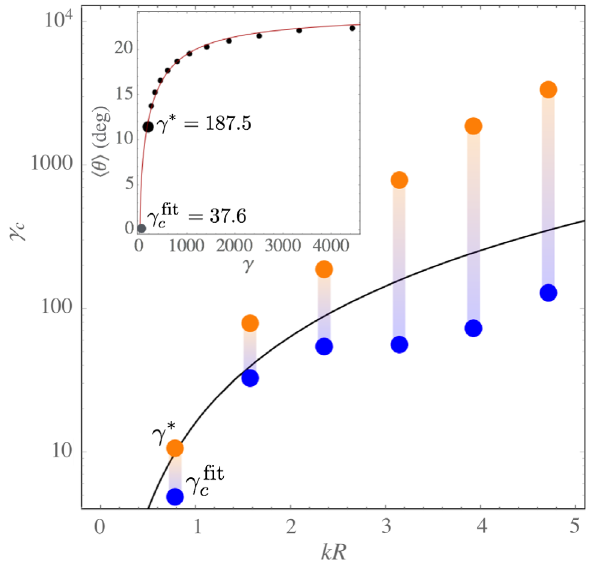
FIG. 6. Confirmation of the linear stability prediction of γ c from Fig. 2 compared to the upper ( γ (cid:4) ) and lower ( γ fit c ) bound estimates for all values of n ¼ 0 – 6 . Inset: Best-fit line from Eq. (20) for the n ¼ 3 data from Fig.